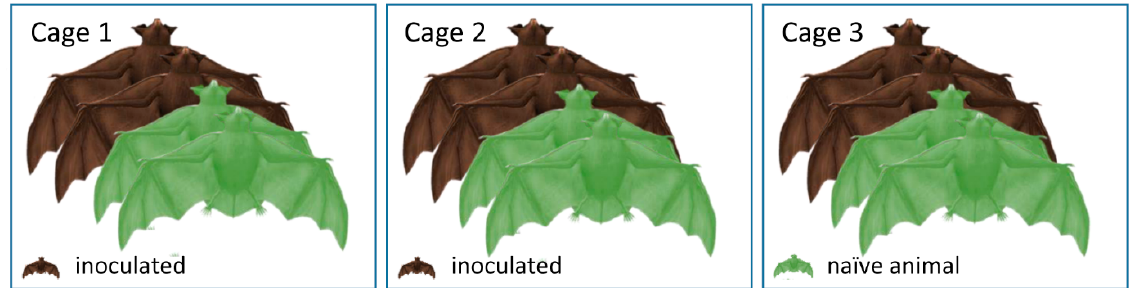
Figure 2. Experimental design of the experiment with A/bat/Egypt/381OP/2017 (H9N2). On 1 dpi, two inoculated and two na ї ve bats were mixed and housed in each of the three cages. This animal distribution was eventually maintained until the end of the experiment.